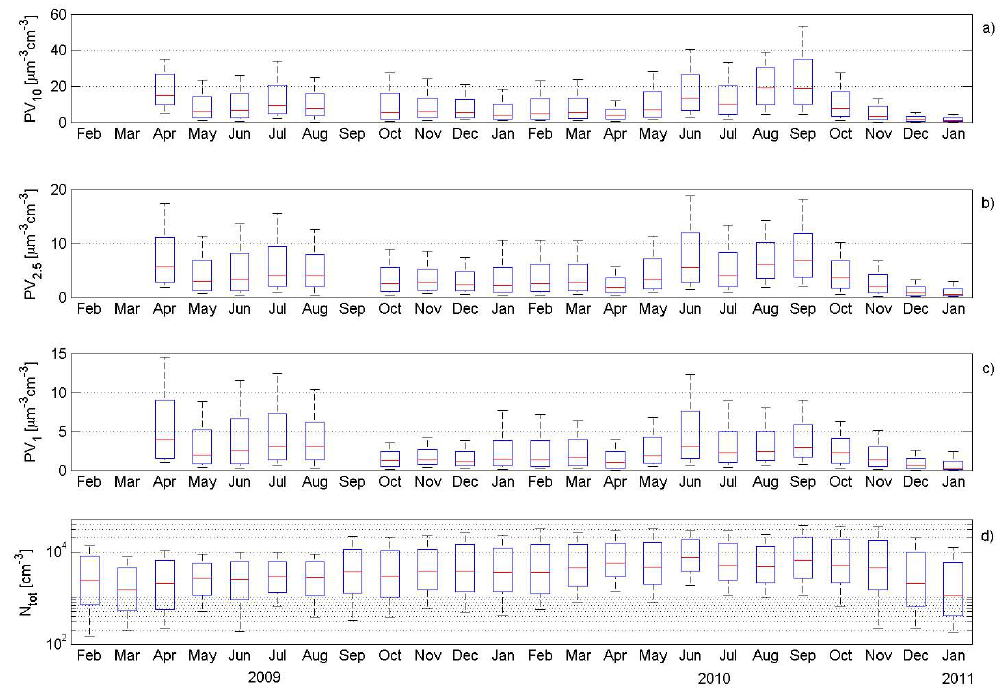
Fig. 7. Aerosol volume and number at Elandsfontein: (a) volume of < 10µm particles, (b) volume of < 2.5µm particles, (c) volume of < 1µm particles, and (d) total number of < 10µm particles for the period 11 February 2009–31 January 2011. The red lines represent the 50% percentile, the blue boxes the 25 and 75% percentiles and the black whiskers the 5 and 95%